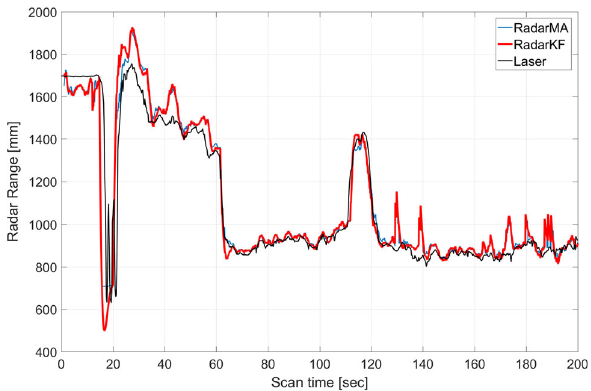
Fig. 16 Radar ( red ) versus laser ( blue ) data for a second, extended, longwall gate road height measurement